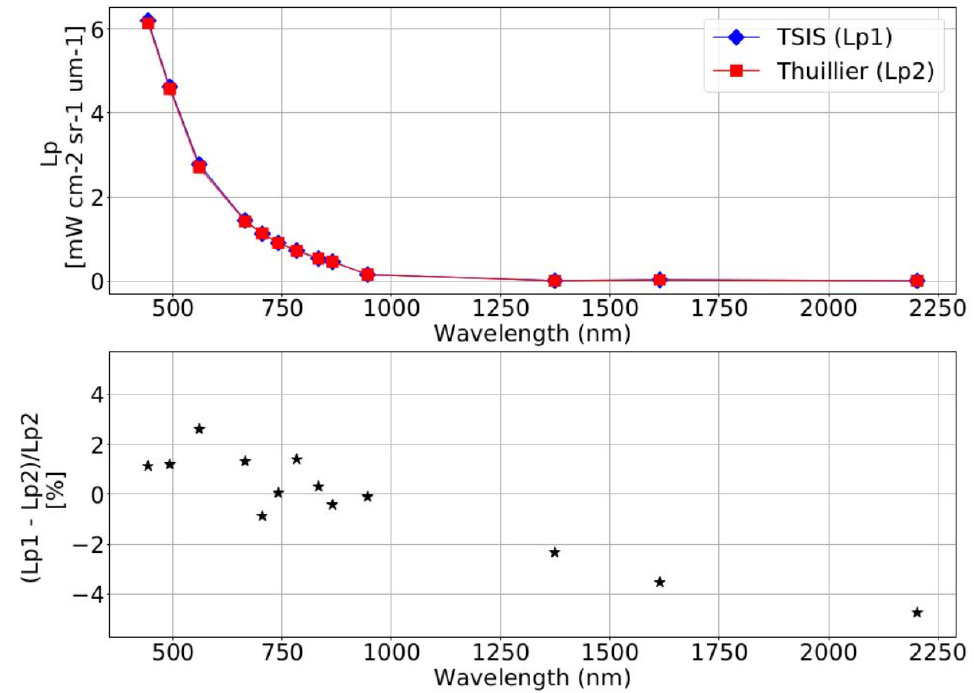
Figure 3. Top : Atmospheric path radiance for Sentinel-2 A bands using Thuillier 2003 (red line) and TSIS (blue line) solar models. Bottom : Relative difference (black stars) between the convolved atmospheric path